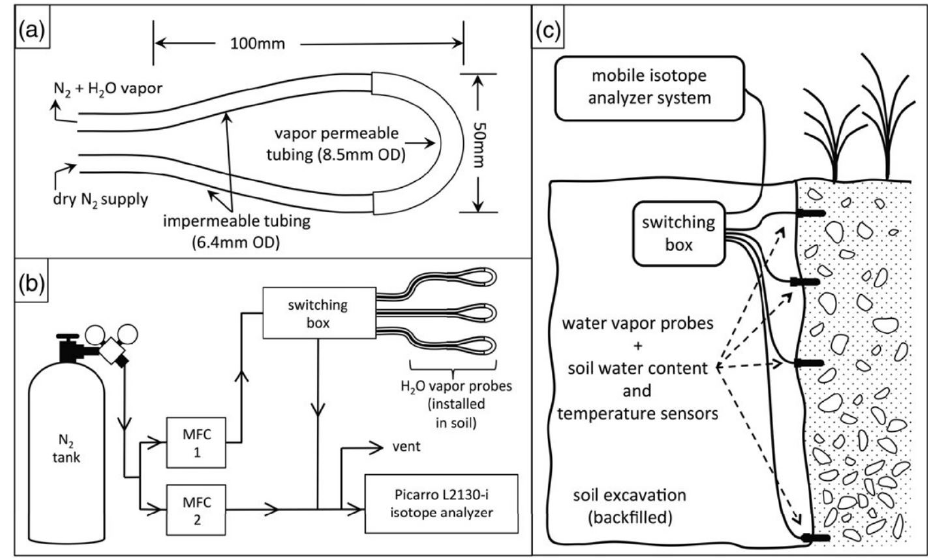
Figure 4. Schematic drawings showing (a) an in situ soil probe consisting of a gas-permeable membrane and attached tubing, (b) a concept of the water vapor probe analytical system, and (c) the field installation of an in situ system with additional sensors for recording soil moisture and temperature. MFC: mass flow controller. Reprinted with permission from Oerter and Bowen (2017). Note that different probe designs exist, and this is only one